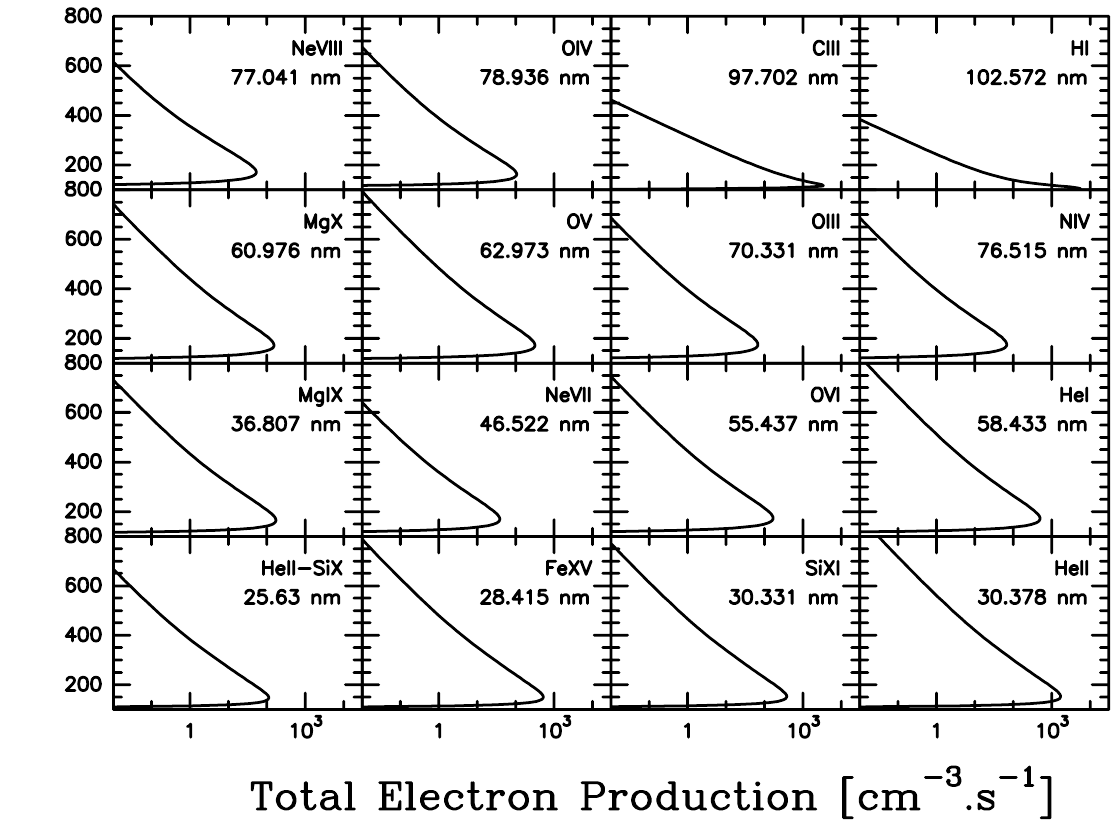
Fig. 3. Electron production rate associated with each of the 16 spectral lines versus altitude in